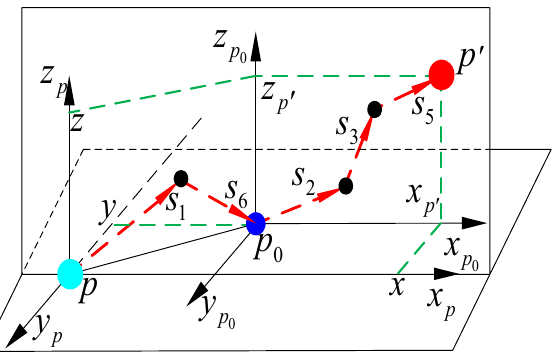
Figure 11. Three-dimensional spatial joint clearance error coordinate system.